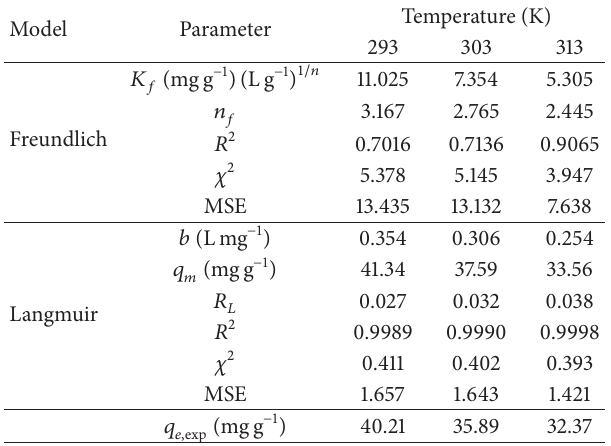
Figure 6: Langmuir isotherm model plots. Table 3: Parameters of isotherm models with statistical analysis values.